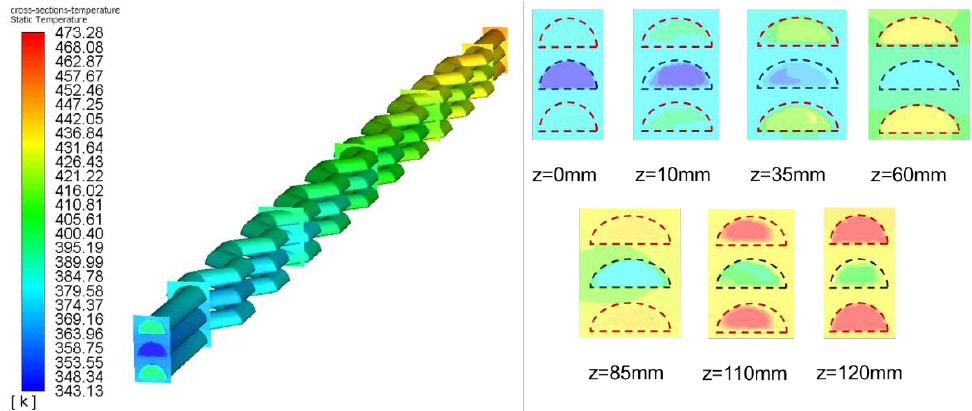
Figure 11. The contours of the three flow channels and seven cross-sections.